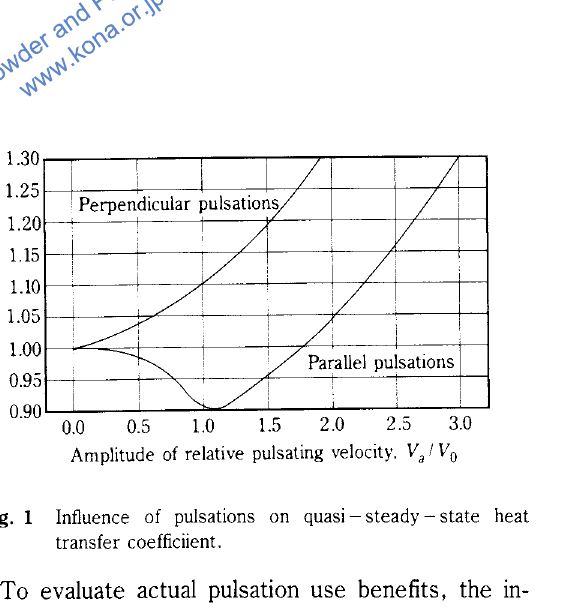
Fig. 1 Influence of pulsations on quasi- steady- state heat transfer